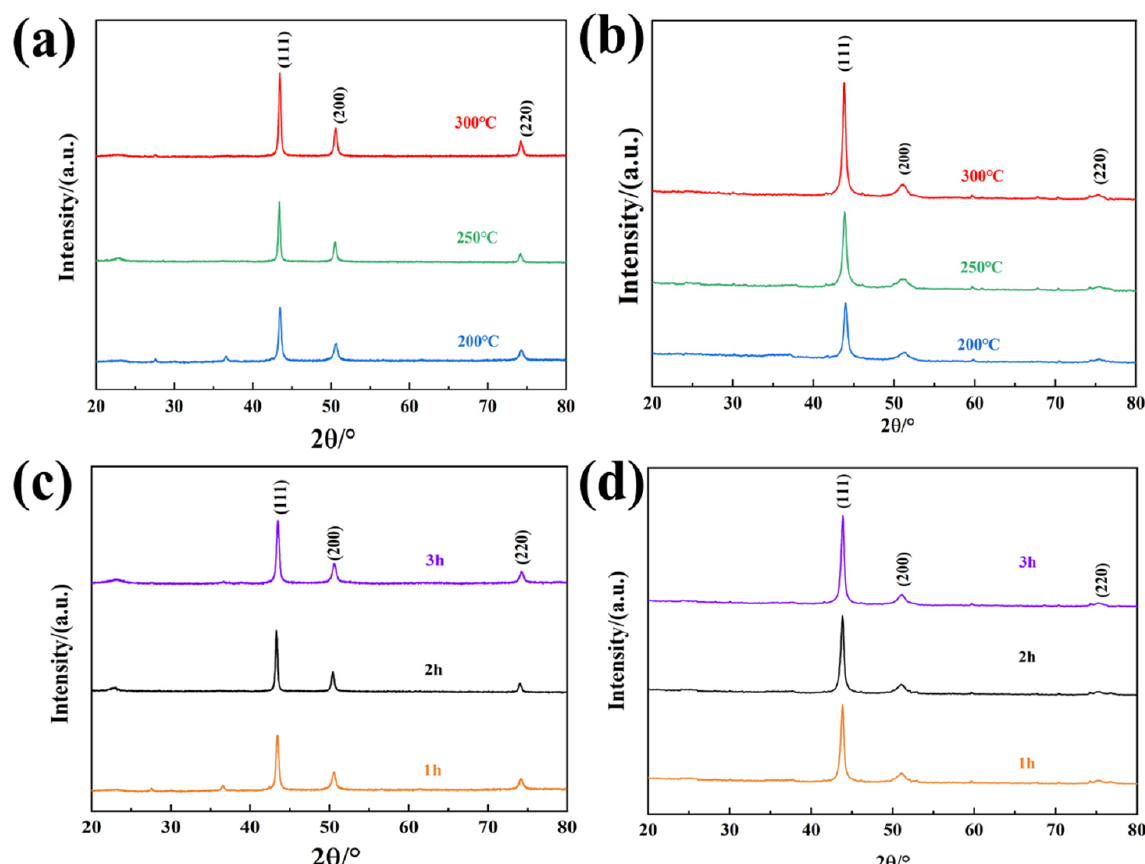
Figure 7. X-ray diffraction at different heat treatment temperatures ( a ) Cu ( b ) CuNi and times ( c ) Cu-250 °C ( d ) CuNi-250 °C.